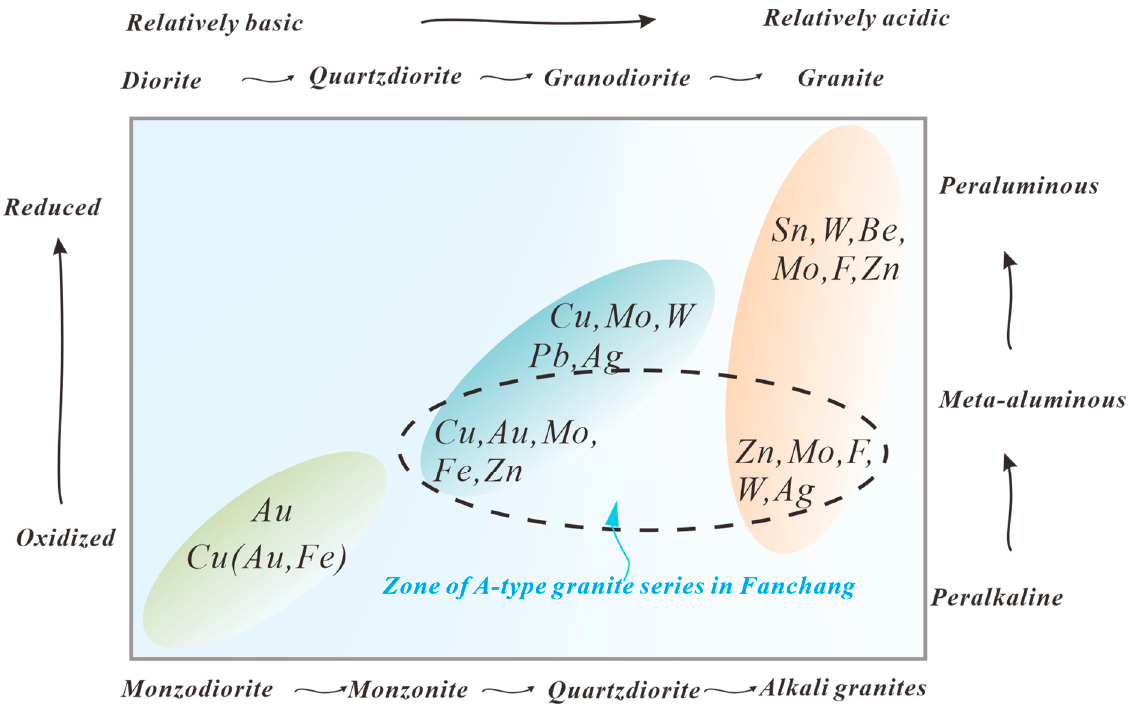
Figure 16. Schematic diagram of associations between mineralization and the chemistry of intrusions plus redox conditions [21,62].